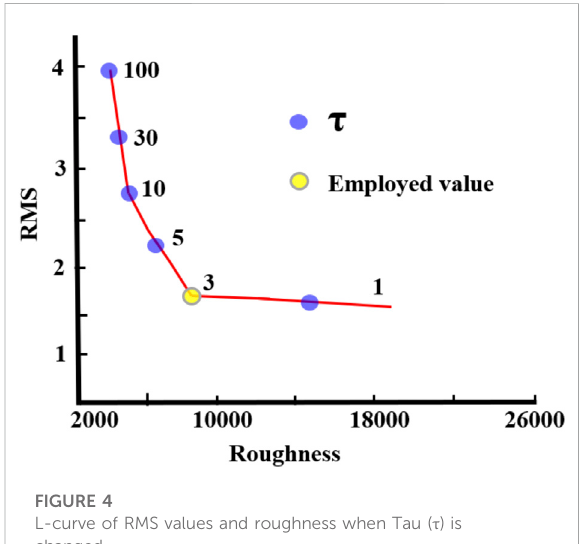
FIGURE 4 L-curve of RMS values and roughness when Tau ( τ ) is